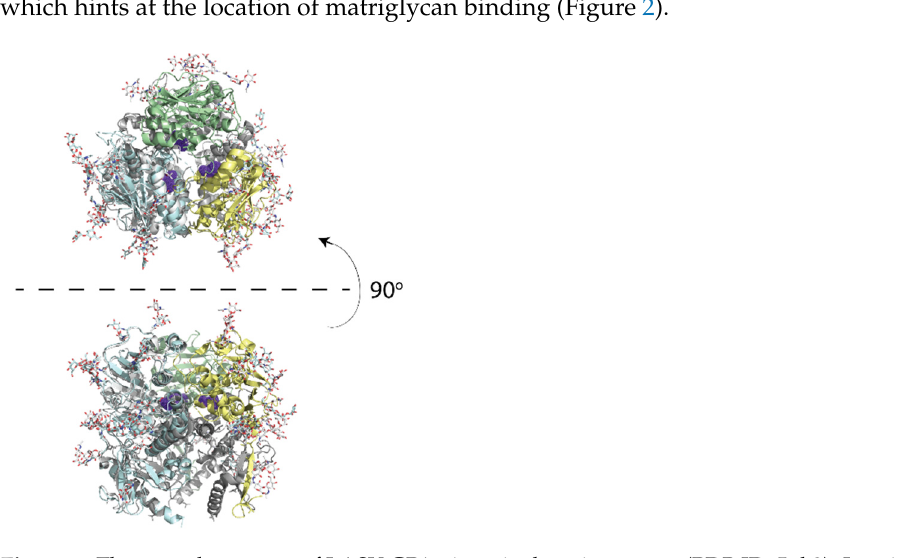
Figure 2. The crystal structure of LASV GP1 trimer is show in cartoon (PDB ID: 5vk2). Leucine-260 is shown in purple on the LCMV trimer. The upper panel shows the top view; the lower panel shows a side view.